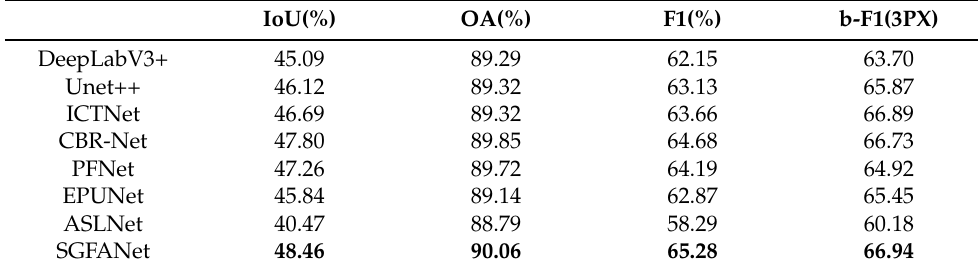
Table 2. Comparison with the related results on the benchmark. The bold values in each column means the best